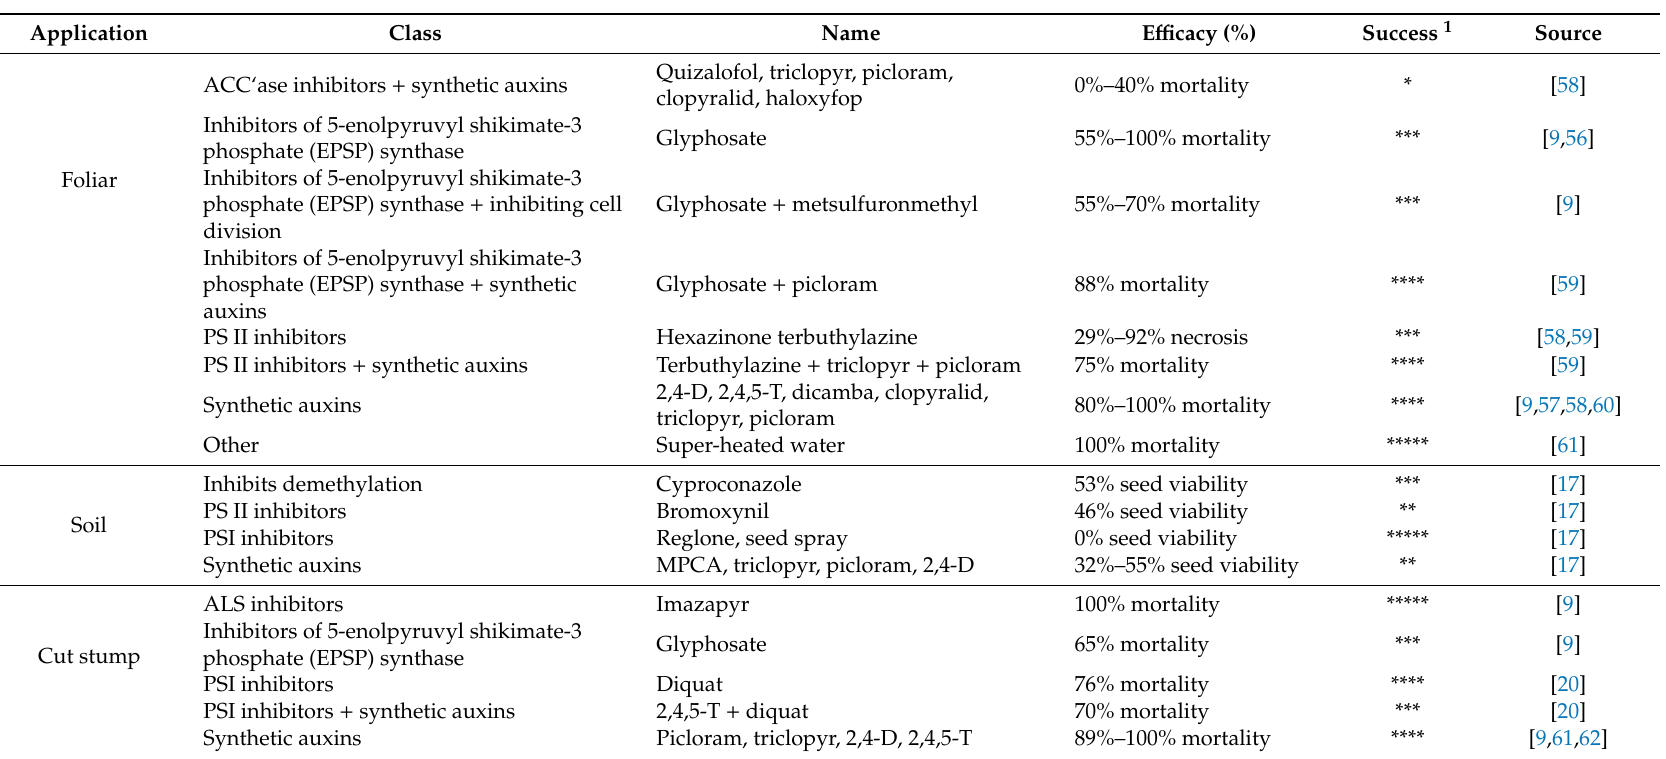
Table 1. Herbicide classes and application techniques evaluated in a global study of the success of management of common